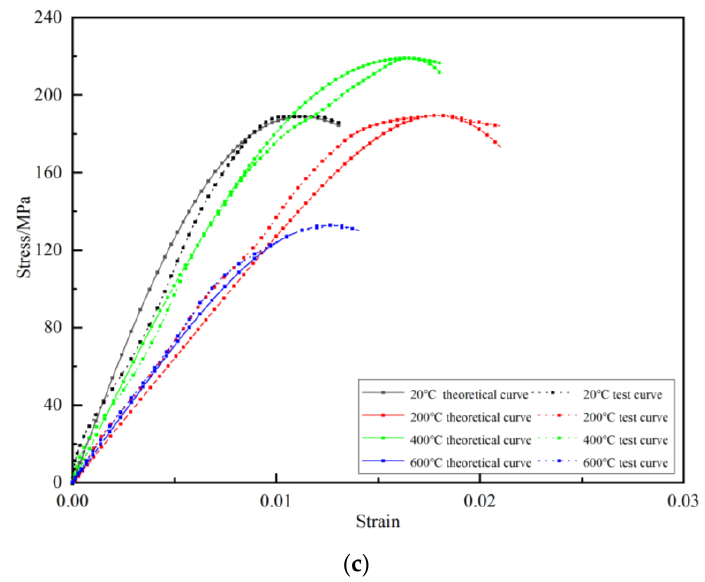
Figure 4. Test curve and theoretical curve fitting. ( a ) Stress–strain curves at different temperatures (5.4 m/s), ( b ) stress–strain curves at different temperatures (8.8 m/s), ( c ) stress–strain curves at different temperatures (11.3 m/s).